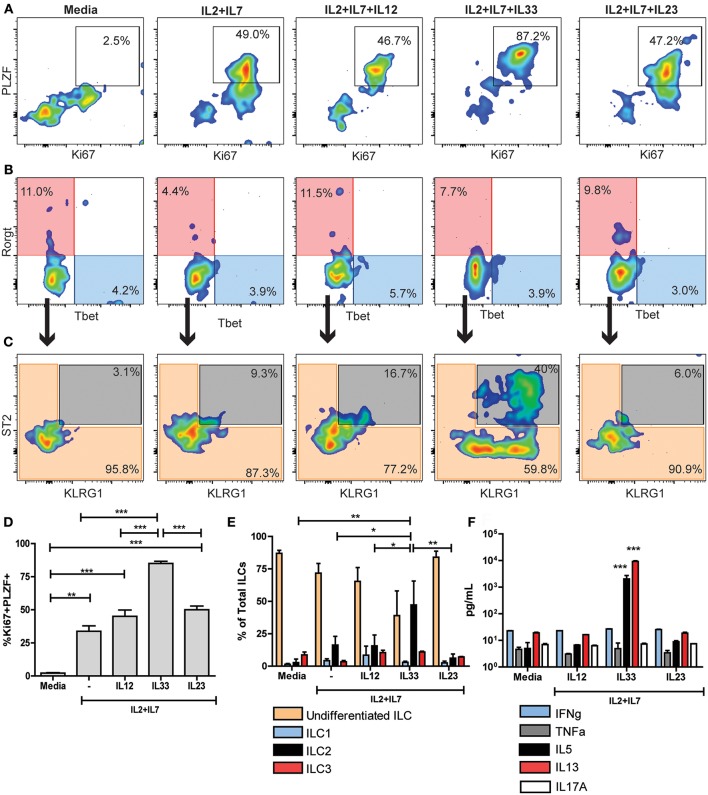
Naïve cardiac ILCs are an ILC type-2 committed population. (A) PLZF/Ki67 activation pattern of ILCs under different in vitro conditions: Media, IL-2+IL-7, IL-2+IL-7+IL-12 (to induce ILC1s), IL-2+IL-7+IL-33 (to induce ILC2s) and IL-2+IL-7+IL-23 (to induce ILC3s). (B) Flow cytometry plots show ILC1 (blue) and ILC3 (transparent red) differentiation under different conditions, based on Rorγt and Tbet expression. (C) Plots show undifferentiated ILCs (transparent orange) and ILC2s (gray) compartments after in vitro stimulation, based on KLRG1 and ST2 expression. (D) Comparison of PLZF+Ki67+ activated population in different conditions. (E) Comparison of different ILC subpopulations after in vitro stimulation. (F) Comparison of cytokine profile determined by ELISA under different stimulating conditions. In F, ***indicates significance of both bars with respect to all other conditions. Flow cytometry plots show median representative examples. Graphics show results of 1 of 4 independent experiments, each one made in triplicates for each condition. Bar graphs shows Mean and SD. Statistics calculated with one-way ANOVA and Bonferroni post-test. *P < 0.05; **P < 0.01; ***P < 0.001.